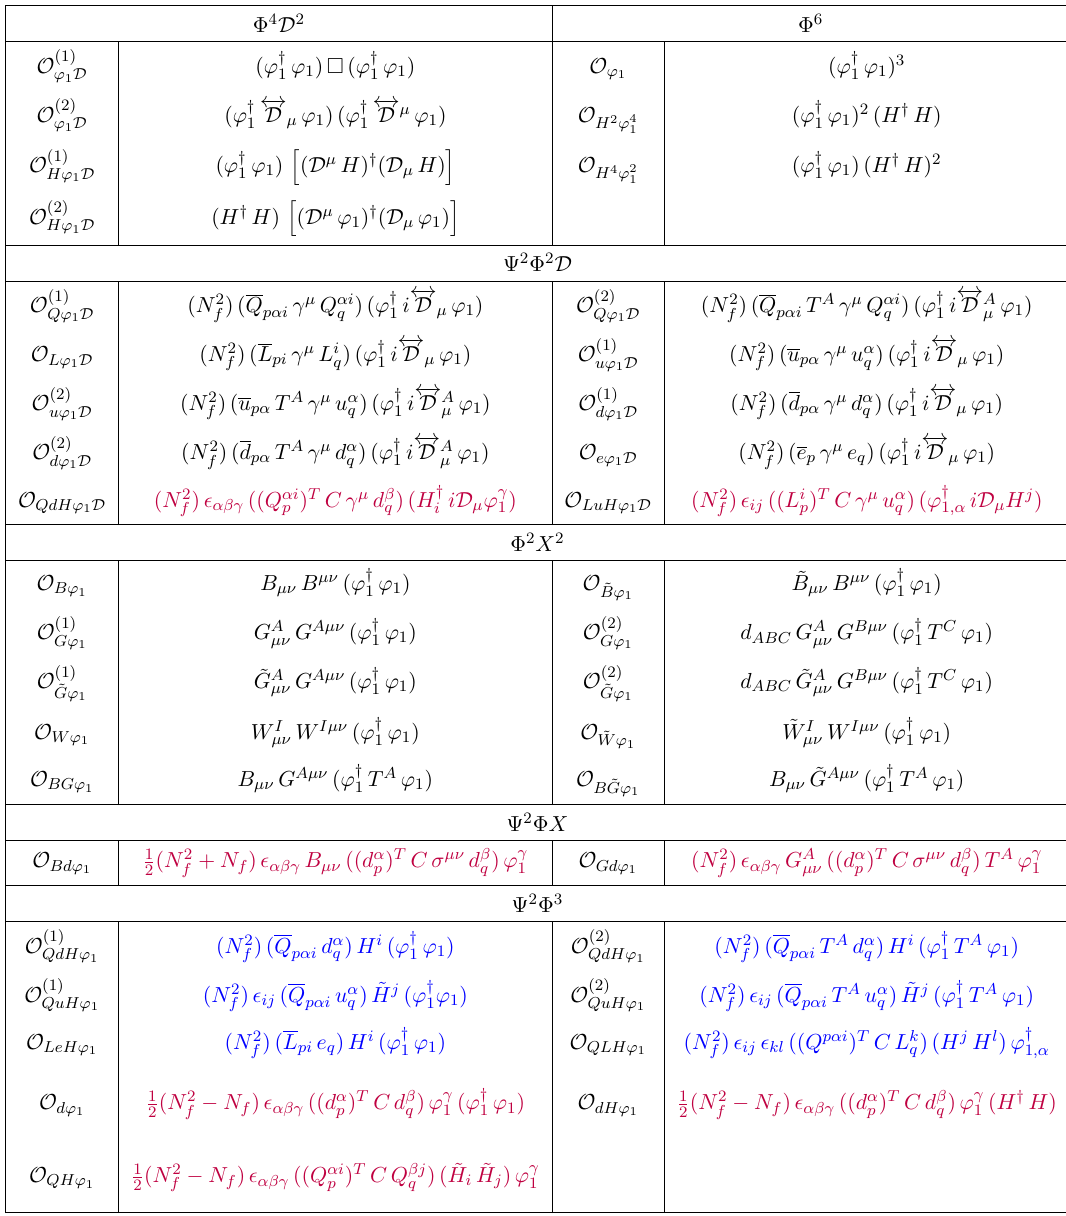
Table 23 . SM extended by Lepto-Quark ( ϕ 1 ): additional operators of dimension 6. Here i, j and α, β, γ are the SU(2) and SU(3) indices respectively. T A are the SU(3) generators. A, B, C = 1 , 2 , · · · , 8 and I = 1 , 2 , 3 . p, q = 1 , 2 , · · · , N f are the flavour indices. Operators in red violate lepton and baryon